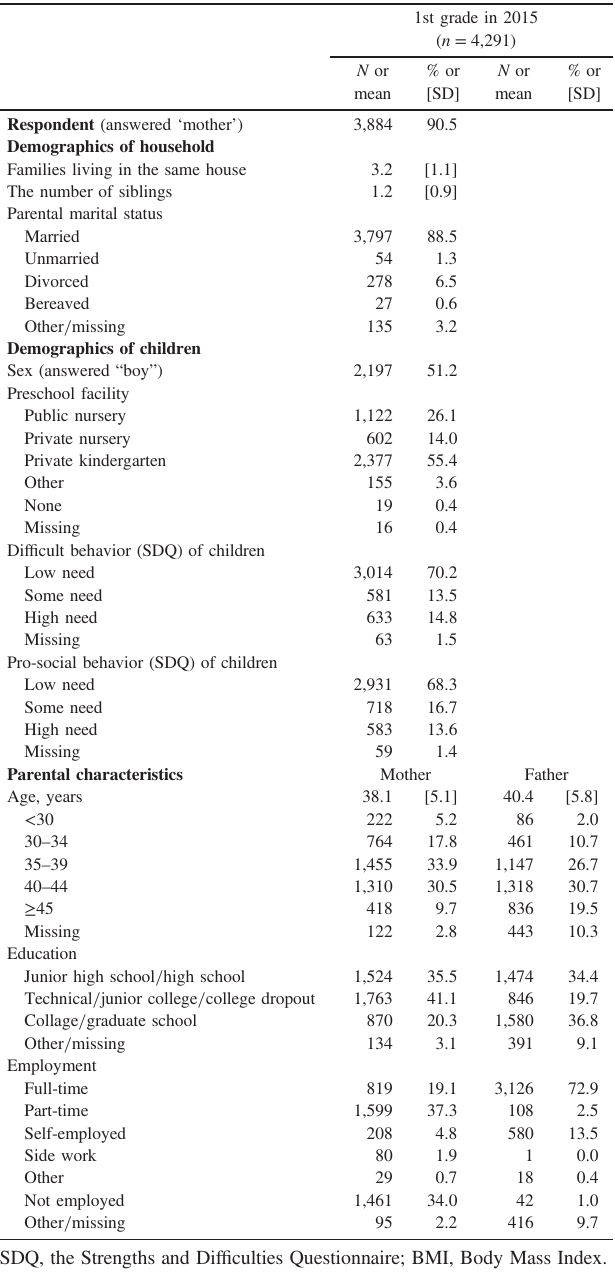
Table 3. Selected pro fi les of the participants for the 1st wave of A-CHILD